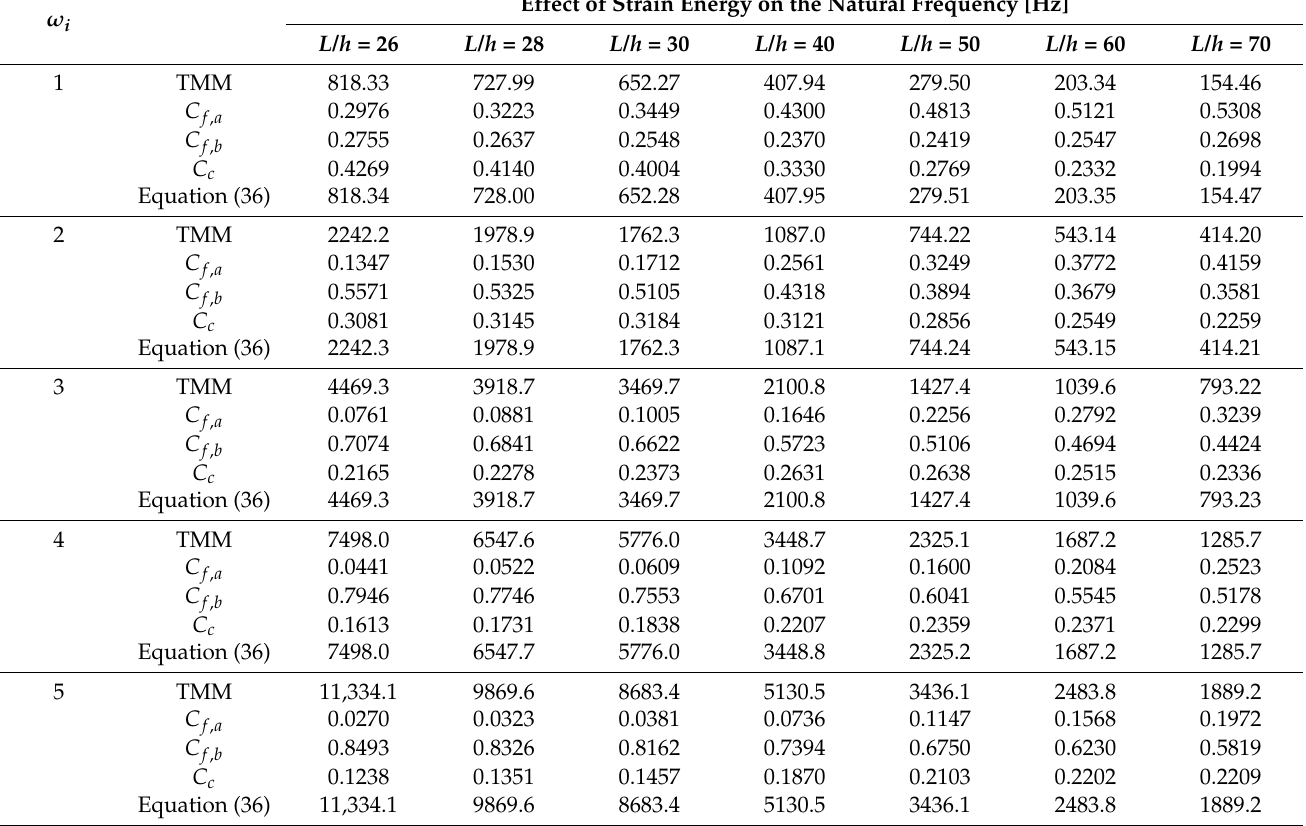
Table 12. Effect of strain energies on the natural frequencies of three-layered beams with the P-P end condition depending on the variation in L/h